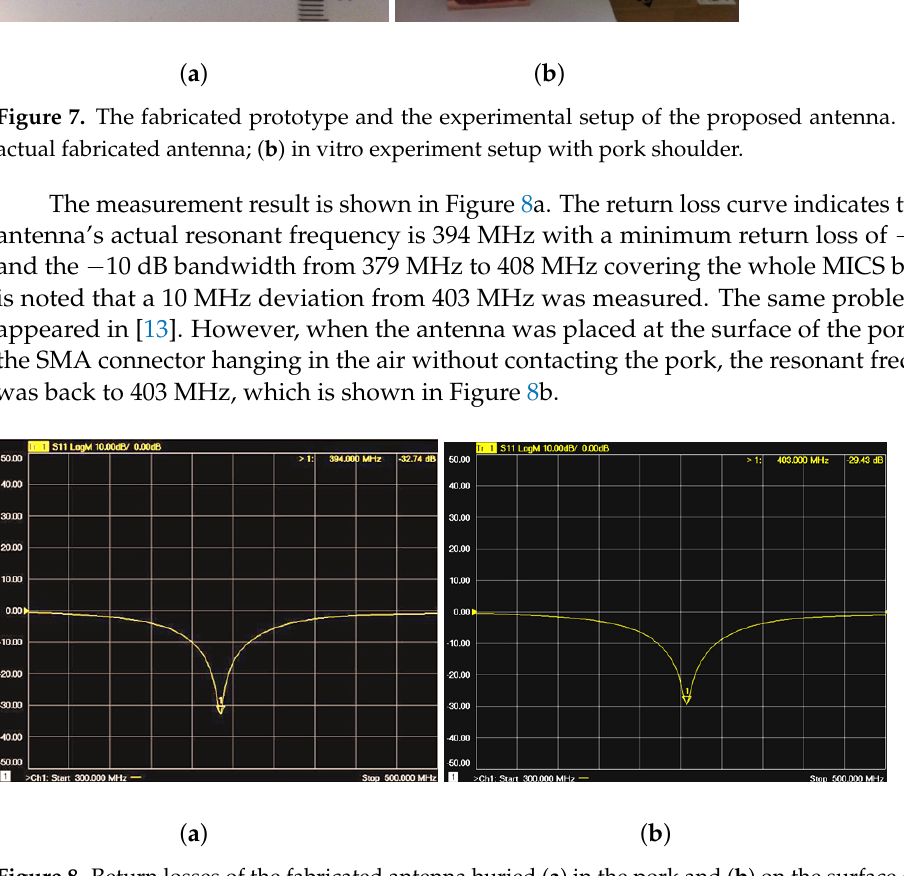
Figure 8. Return losses of the fabricated antenna buried ( a ) in the pork and ( b ) on the surface of